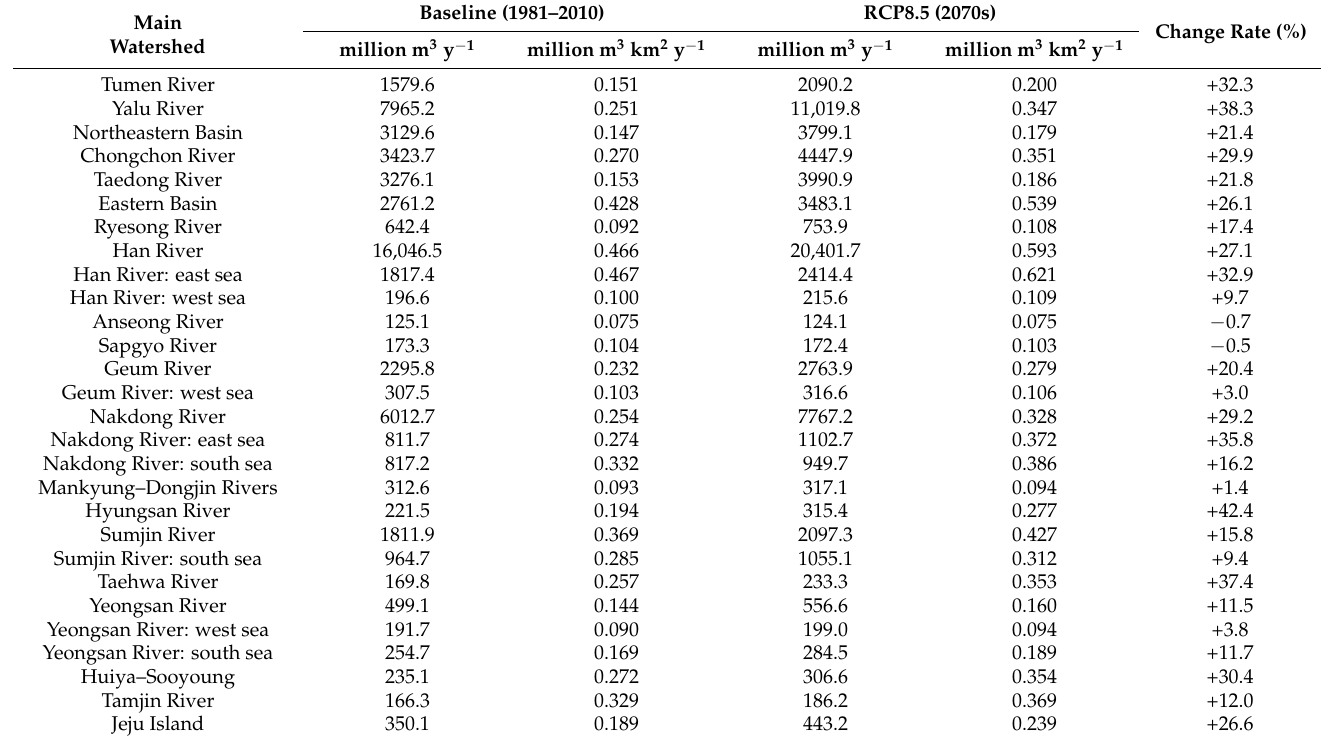
Table 5. Water supply–demand balance under climate change at the main watershed level. Main